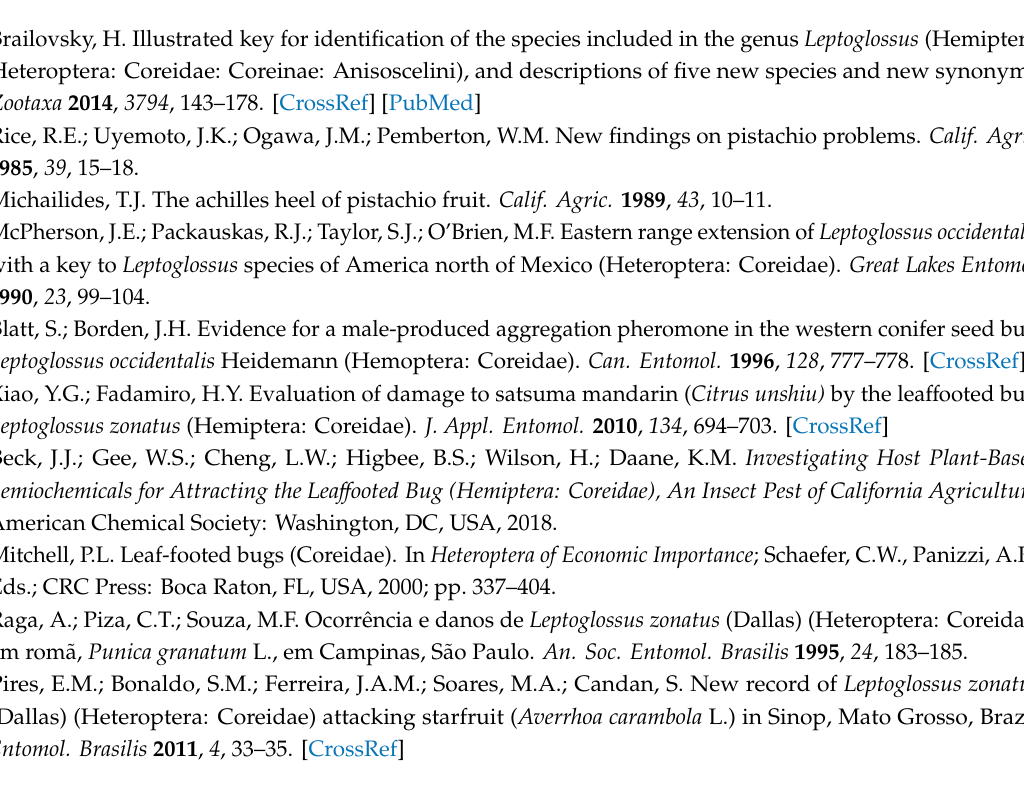
Table S1: The 2014 percent almond drop in four treatments in four almond varieties. CO = control, PU = punctured, CL = L. clypealis , and ZO = L. zonatus . n / a = no observation in that week, Table S2: Comparison of weekly almond drop from feeding by L. clypealis within each variety in 2014. Percent almond drop is compared in each two weeks of observations by Fisher’s exact tests. p < 0.05 is significant and shown in bold. (-) indicates no comparisons due to no observation in week 1 or 7 in Monterey or Carmel varieties. Table S3: Comparison of weekly almond drop from feeding by L. zonatus within each variety in 2014. Each comparison is between percent almond drop in two weeks of observations. Comparisons are by Fisher’s exact tests and p < 0.05 is considered significant and shown in bold. (-) indicates no comparisons due to no observation in week 1 or 7 in Monterey or Carmel. Table S4: The 2015 weekly percent almond drop in four treatments in four almond varieties. The date corresponds to the observation week in the study.CO = control, PU = punctured, CL = L. clypealis, and ZO = L. zonatus. n / a = no observation in that week. Table S5: Weekly almond drop by L. zonatus within each variety in 2015. Each comparison is percent almond drop in between two weeks (Fisher’s exact tests; p < 0.05). (-) indicates no observation week 3 in Nonpareil and Fritz, and week 1 in Monterey or